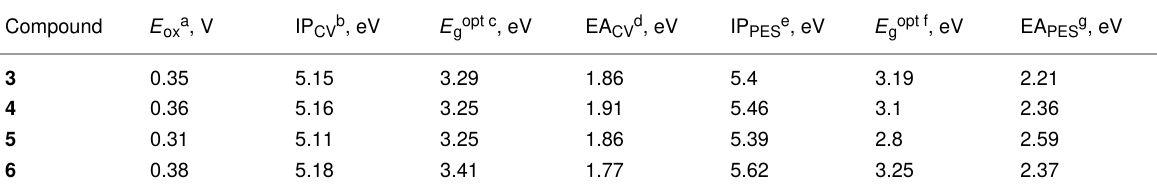
Table 2: Electrochemical properties of compound 3–6